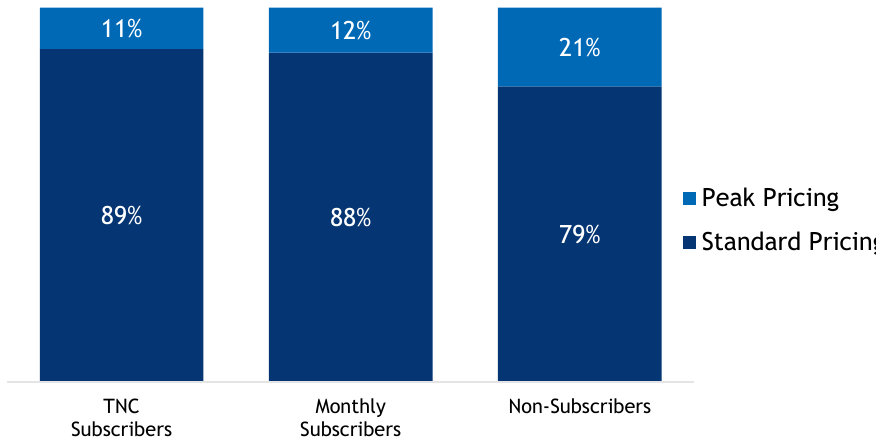
Figure 11. Peak pricing energy consumption by Electric Avenue user group.